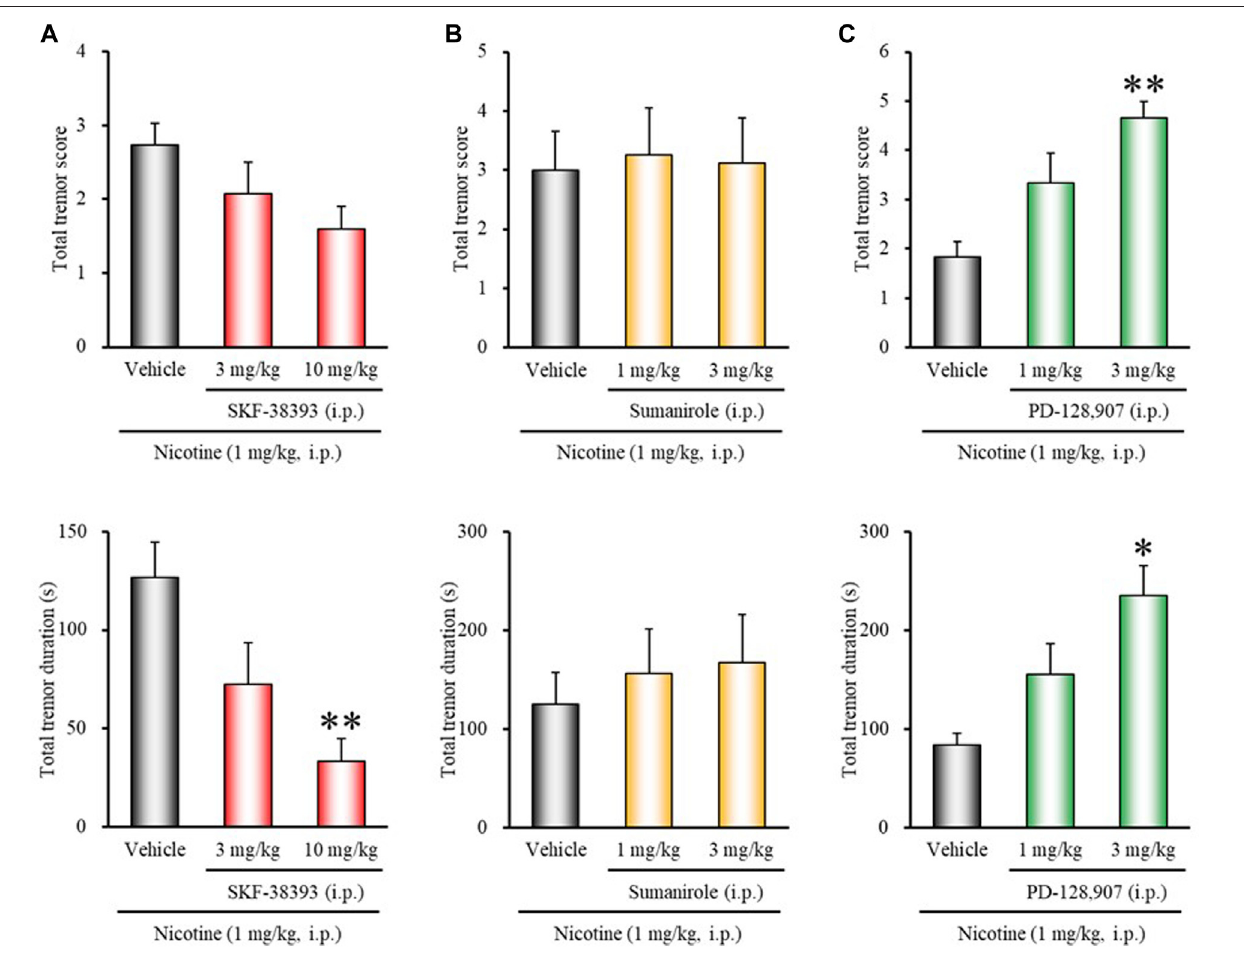
FIGURE1 | Effects ofdopamine receptor agonists on nicotine-induced tremor inmice. Mice weretreated with: (A) the D 1/5 agonist SKF-38393 (3, 10 mg/kg,i.p.), (B) the D 2 agonist sumanirole (1, 3 mg/kg, i.p.), (C) the D 3 agonist PD-128,907 (1, 3 mg/kg, i.p.), or vehicle (control) 15 min before the nicotine (1 mg/kg, i.p.) injection. Datashowthetotaltremorscore(intensity)anddurationofnicotine-inducedtremoroverthe10 minobservationperiod.Eachcolumnrepresentsthemean±S.E.M.* p < 0.05, ** p < 0.01: Signi fi cantly different from control